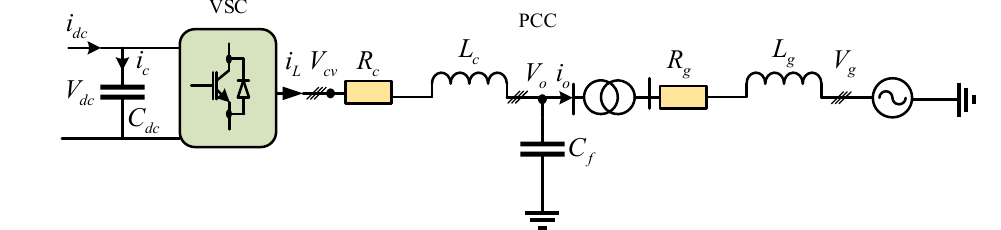
Figure 5. Structure of the VSC-based HVDC converter connected to the AC system.